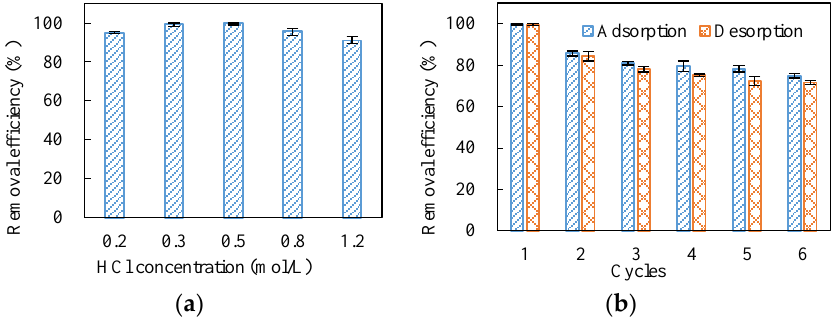
Figure 9. ( a ) Effect of HCl concentration on the desorption capacity of Pb 2+ ; ( b ) adsorption – desorption cycles ( C 0 = 100 mg/L, m/v = 0.3 g/L, the HCl concentration is 0.5 mol/L, T = 298 K). Figure 9 indicates that the desorption rate of Pb 2+ by the HCl solution with a concentration of 0.2, 0.3, 0.5, 0.8, and 1.2 mol/L was greater than 91% in all cases, indicating that HCl can be used as a